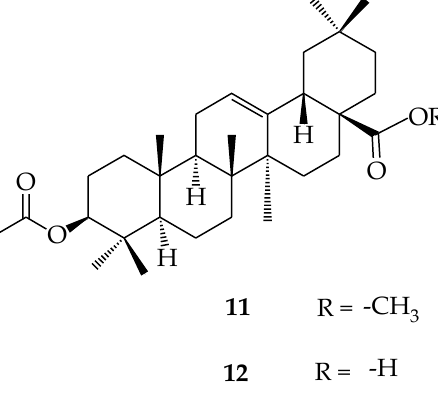
Figure 4. 3-acetoxy, 28-methyloleanolic acid ( 11 ); 3-acetoxyoleanolic acid (12 ).